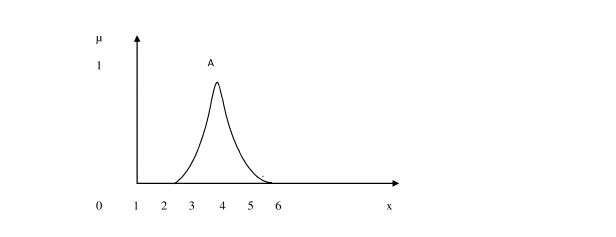
Figure 4. Fuzzy group A membership function.